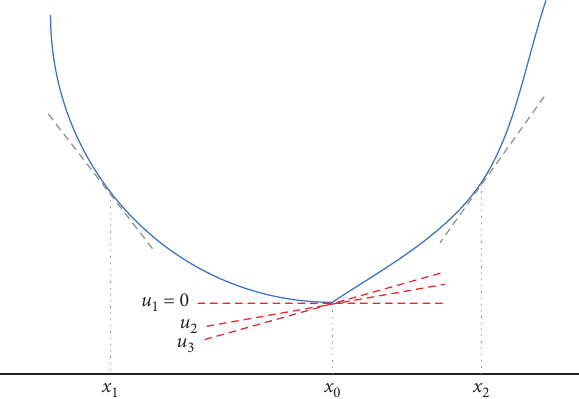
Figure 1: The subgradients of a nonsmooth